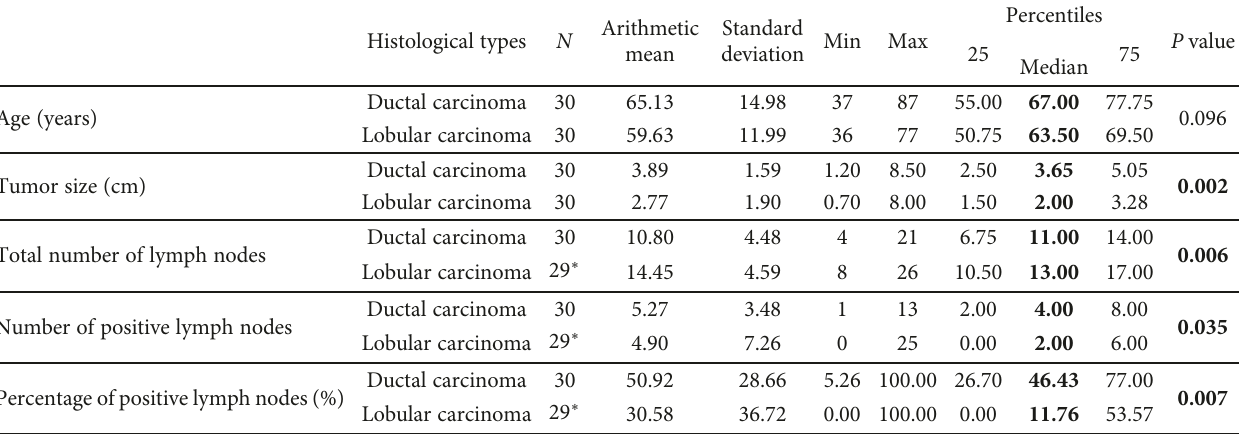
Figure 8: Strong Sdc1 expression in the tumor epithelium of the ductal carcinoma metastasis in the axillary lymph node (the micropapillar histological subtype) (the same slide, IHC; × 100 for (a), × 200 for (b), and × 400 for (c)). Table 1: Di ff erences in the investigated quantitative values between the invasive ductal and lobular breast carcinomas: the statistical analysis was done with the Mann – Whitney U